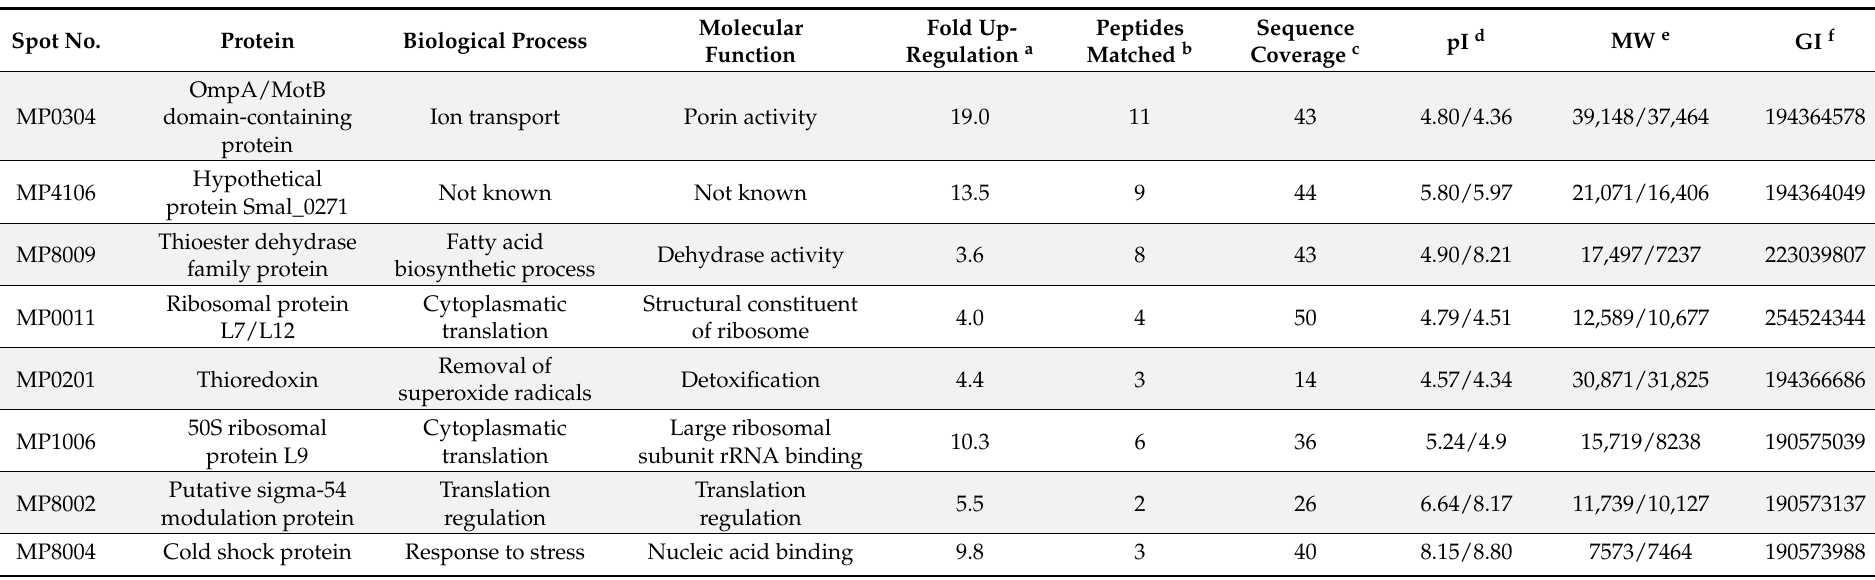
Table 3. Proteins (n = 8; signal > 1000 ppm; ≥ 3-fold vs . biofilm growth; p < 0.01, t -test) significantly downregulated in biofilm-grown S. maltophilia Sm126 cells. Spot